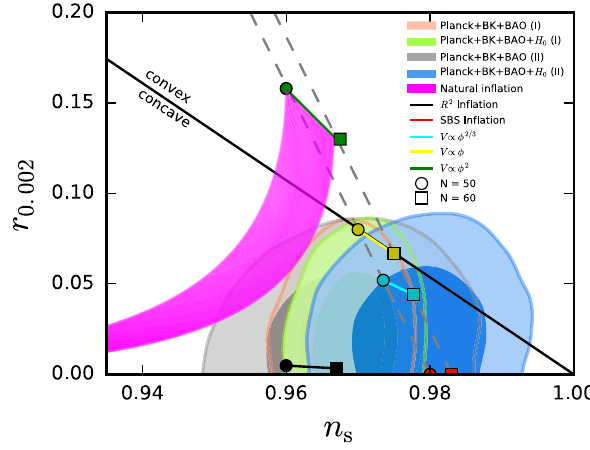
Fig. 6 Two-dimensional contours (1 σ and 2 σ ) for n s and r 0 . 002 using the Planck + BK + BAO and Planck + BK + BAO + H 0 data, compared to thetheoreticalpredictionsofselectedinflationmodels.(I)and(II)corre- spondtotheconstraintsonthe (cid:2) CDM + r and (cid:2) CDM + r + N eff